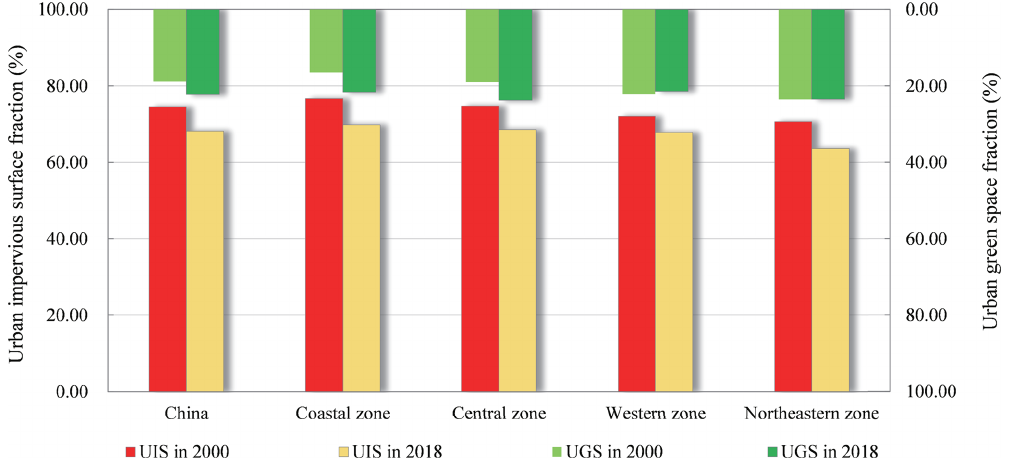
Figure 11. The fractions of urban impervious surface (UIS) and urban green space (UGS) at national and regional scales (coastal, central, western and northeastern zones) in 2000 and 2018.